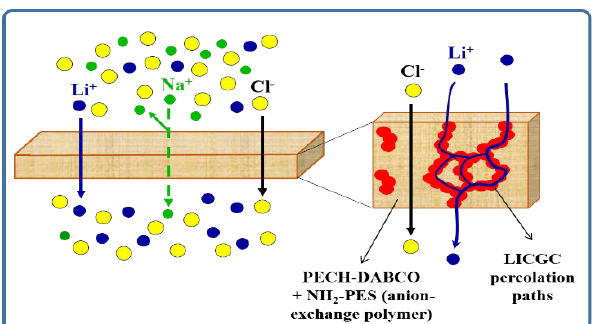
Figure 2. Schematic illustration of ionic diffusion through the LCM5. Adapted from [75,76].